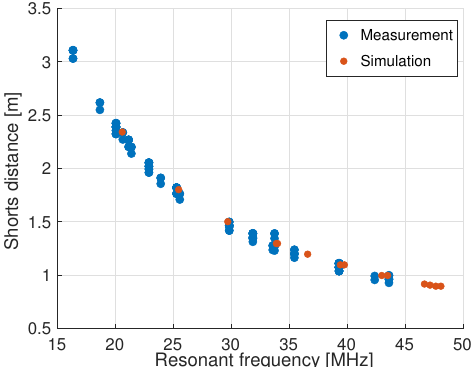
Figure 5. Sliding short distance from the median plane vs. TEM mode frequency. Eigenmode simulations performed with CST (red dots) are compared with experimental measurements (blue